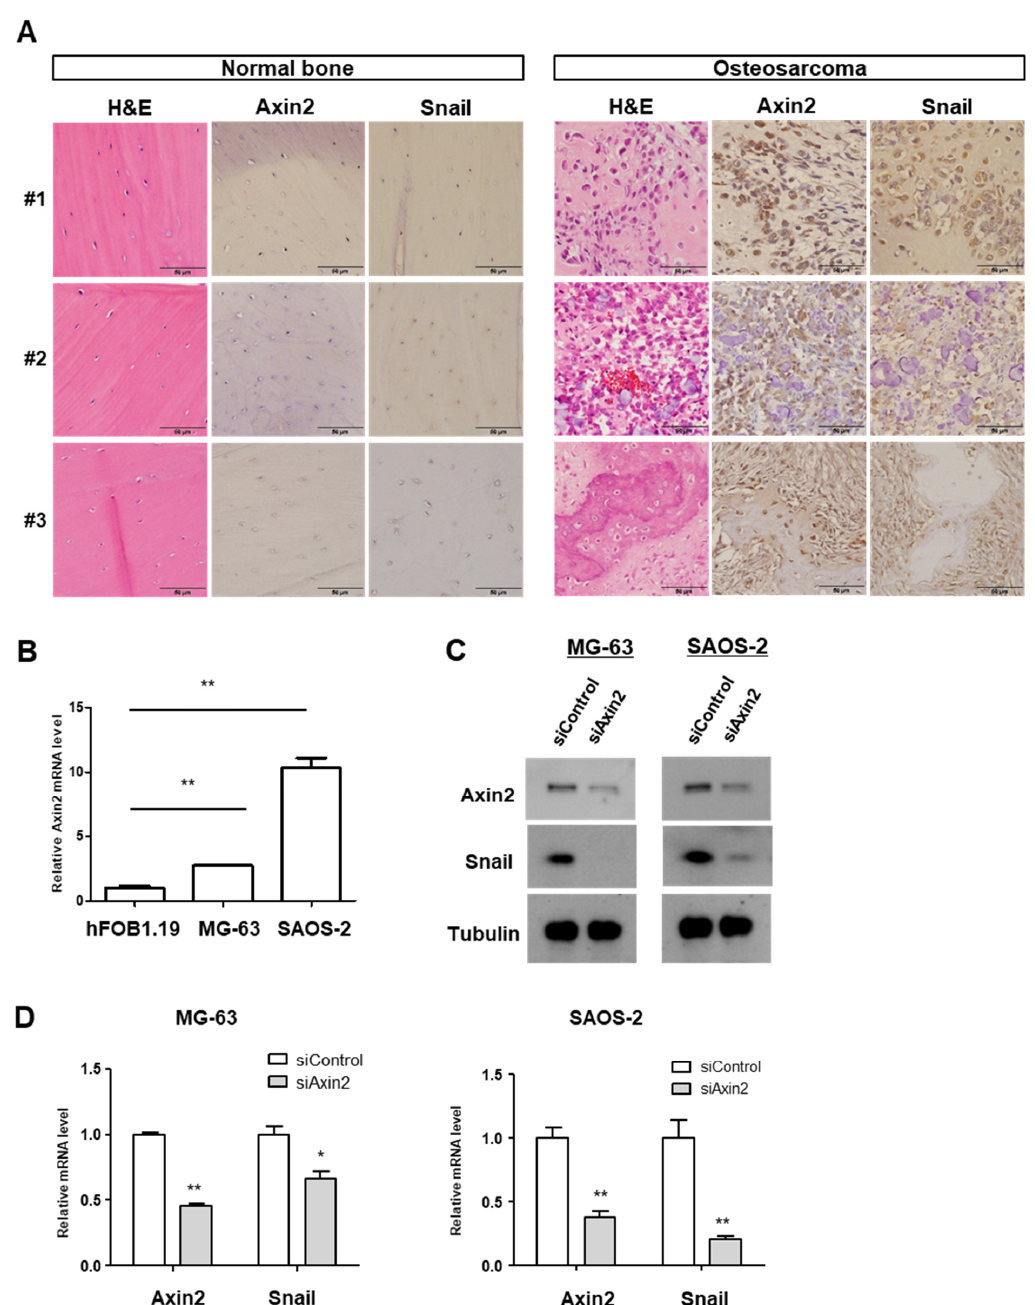
Figure 1. Axin2 and Snail are highly expressed in clinical tissue samples and cells of osteosarcoma. ( A ) Routine H&E staining and Axin2 and Snail immunohistochemical staining in adjacent normal bones (let panel) and tumor samples (right panel) in three patients with osteosarcoma. Photomicrographs were obtained at ×400 magnification. Scale bar = 50 μ m. ( B ) The Axin2 mRNA levels of osteosarcoma cell line (MG-63, SAOS-2). The level was presented as the fold change relative to that of the hFOB1.19 cells. Quantitative RT-PCR was carried out in triplicate, at the minimum (error bars, ± SD. ** p < 0.01 versus hFOB1.19). ( C ) Axin2 and Snail protein levels of osteosarcoma cell treated with niclosamide and pyrvinium by using Western blotting. Representative images are shown from at least two independent experiments. For uncropped figures, see Figure S1. ( D ) The Axin2 and Snail mRNA level in Axin2 knockdown cells. Cells were transfected with scrambled control and siAxin2. Axin2 and Snail transcript abundance was analyzed with quantitative RT-PCR. Quantitative RT-PCR experiments were carried out in triplicate, at the minimum (error bars, ± SD. * p < 0.05, ** p < 0.01 versus